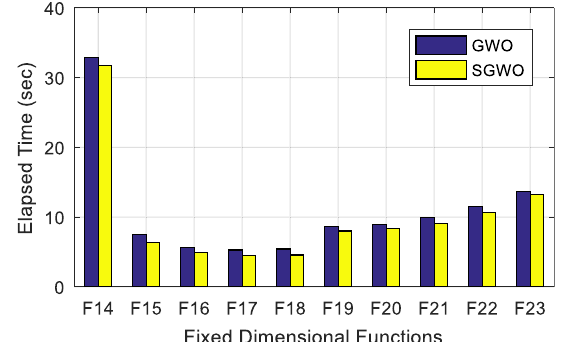
Fig. 8 Fixed dimension function ’ s execution